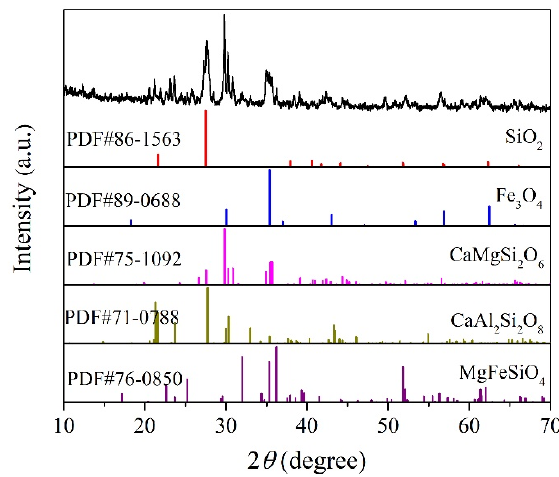
Figure 1. XRD patterns of the OB (plagioclase (CaAl 2 Si 2 O 8 ), pyroxene (CaMgSi 2 O 6 ), quartz (SiO 2 ), olivine (MgFeSiO 4 ), and magnetite (Fe 3 O 4 )).